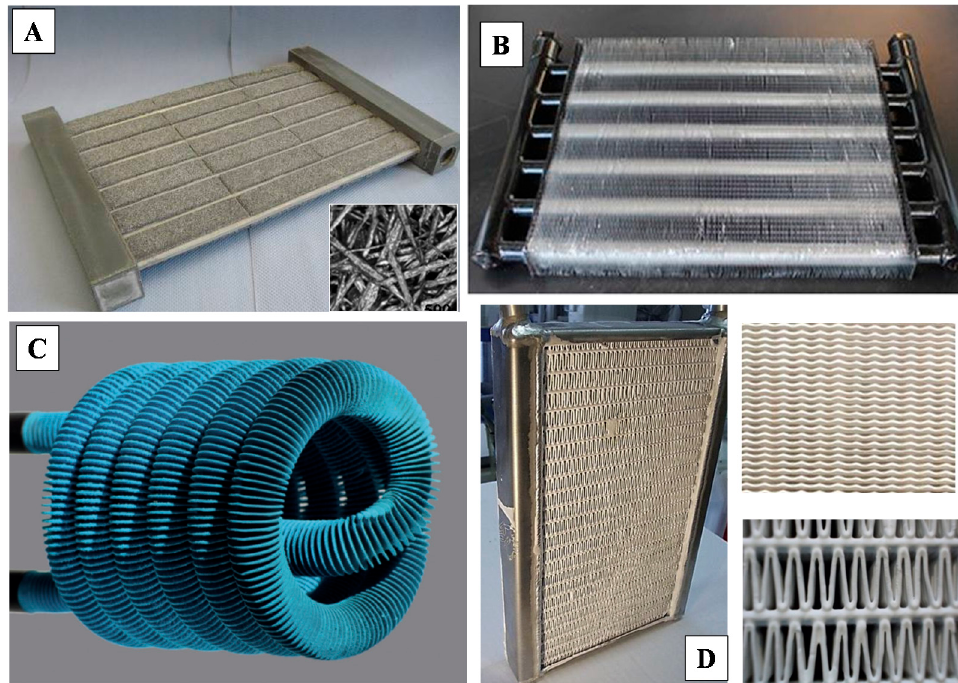
Figure 7. Examples of full scale coated adsorbers realized and tested under controlled conditions. ( A ) In situ SAPO 34 crystallized on a composite fiber heat exchanger [52]. ( B ) Binder-based AQSOA 02 coating on a finned-tube HEX [76]. ( C ) Binder-based aluminum fumarate coating on a finned tube heat exchanger [24]. ( D ) Binder-based SAPO 34 coating on a finned–flat-tube aluminum heat exchanger [18]. (Copyright from Elsevier 2012)